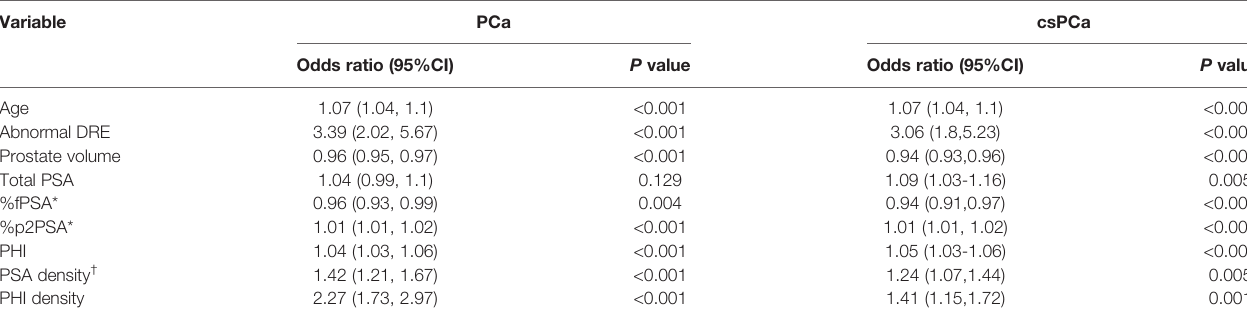
TABLE 2 | Univariable logistic regression models for the prediction of PCa and csPCa. Variable